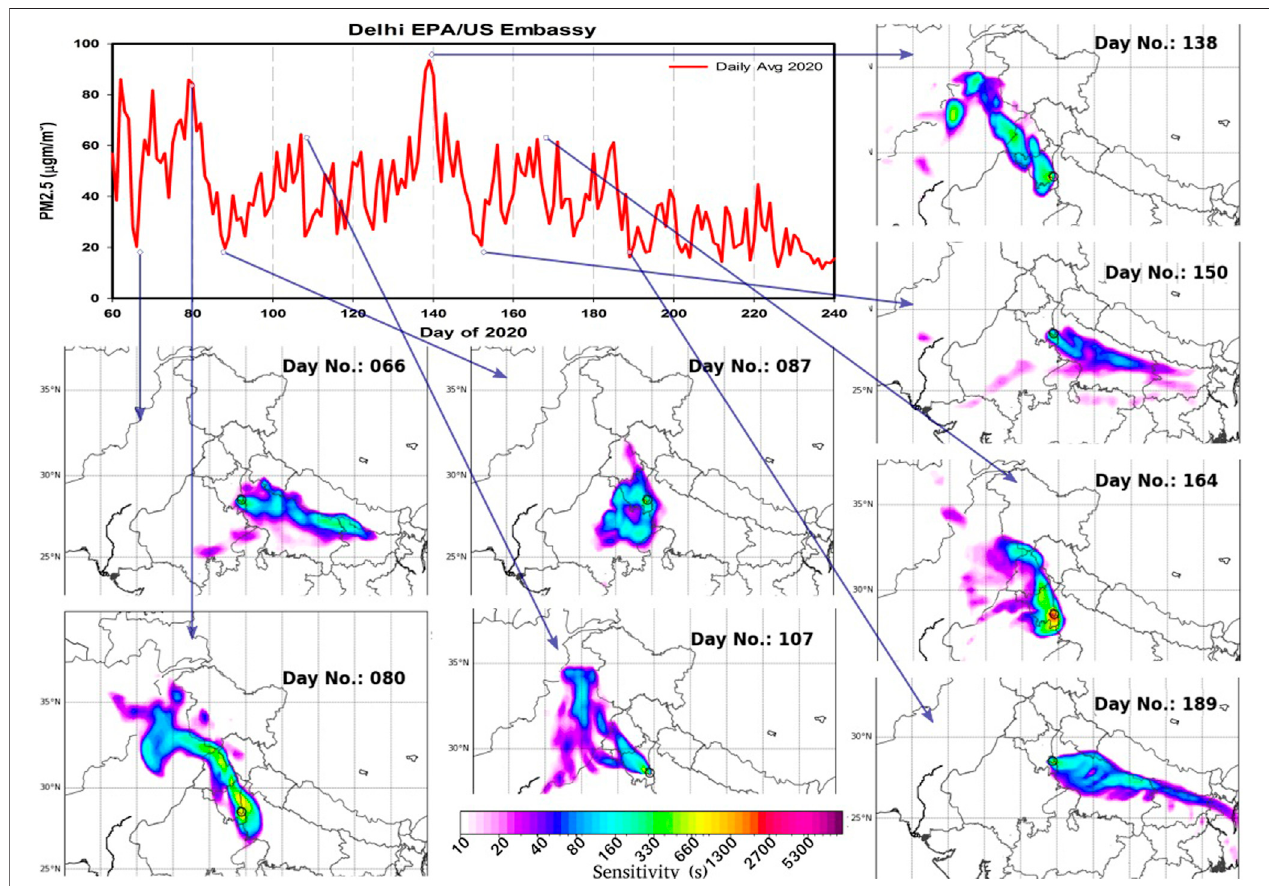
FIGURE 7 | FLEXPART-based source region estimations for Delhi during months corresponding to COVID-19 lockdown and unlock phases during 2020 and comparison with previous years. The sensitivity (s) is given in seconds.